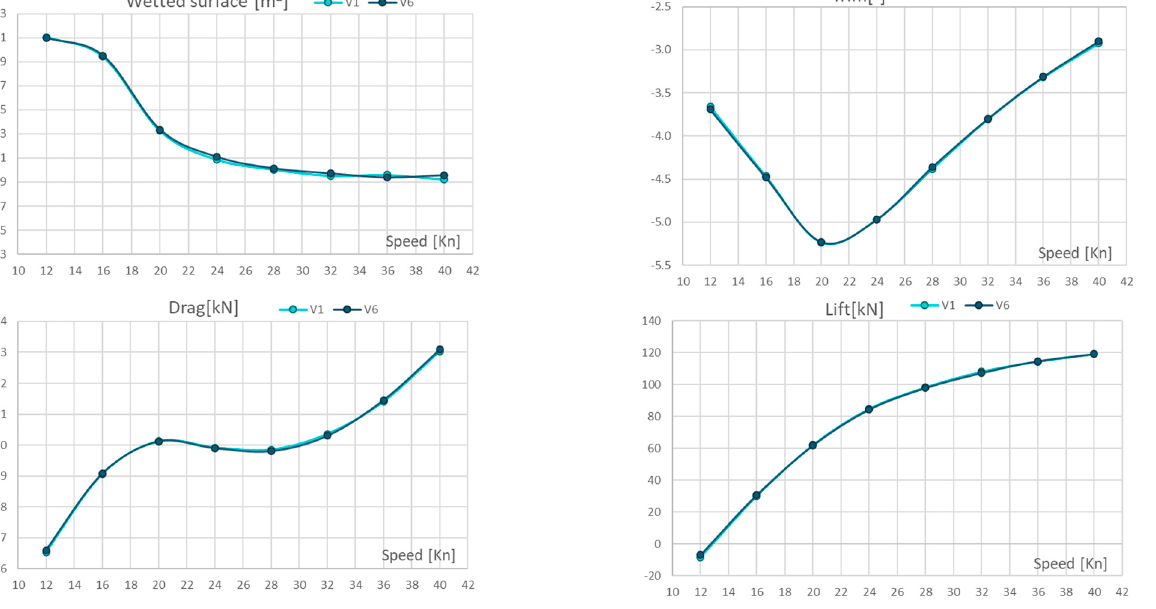
Figure 8. Variation of main computed parameters with respect to boat speed.